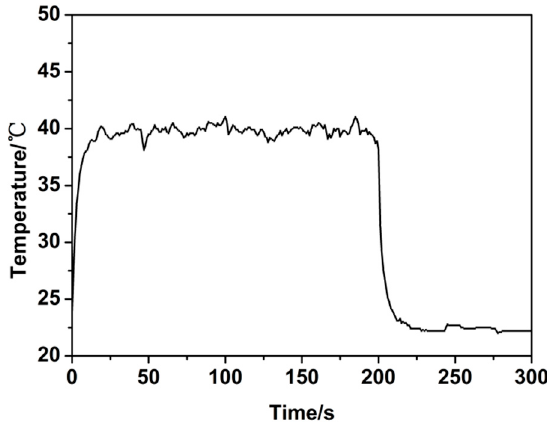
Figure 6. Electro-thermal response of heating system at 2.5 V.